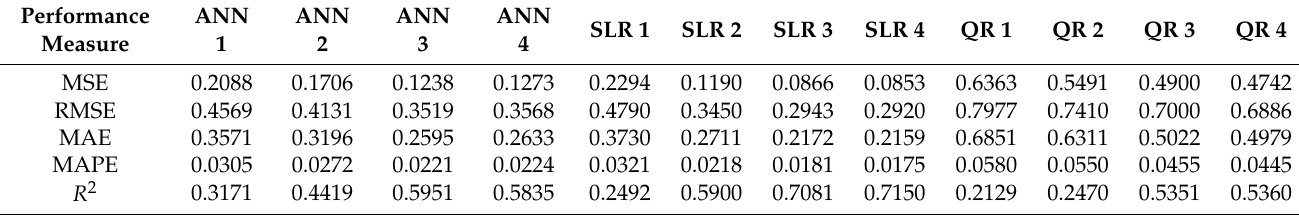
Table 5. Comparison of the performance of the ANNs, SLRs and QRs for dataset